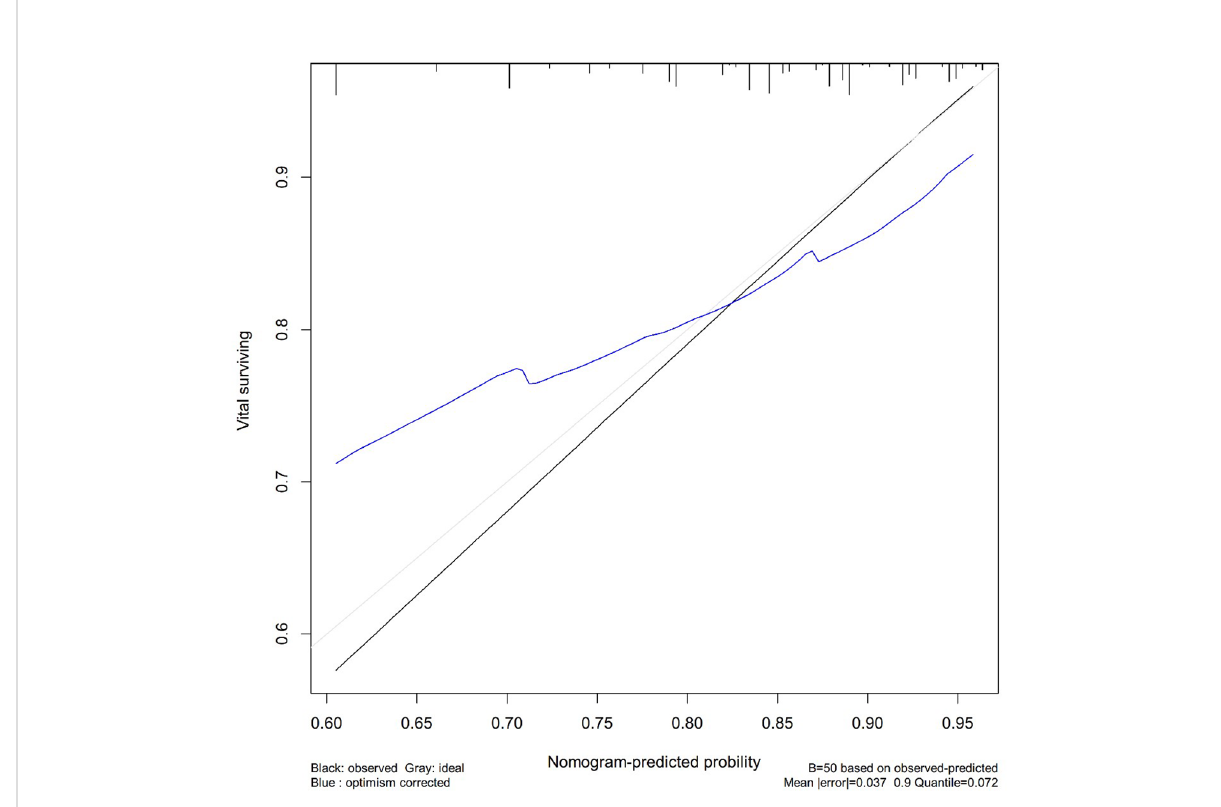
FIGURE 4 The calibration plot established for the nomogram among patients of stage I